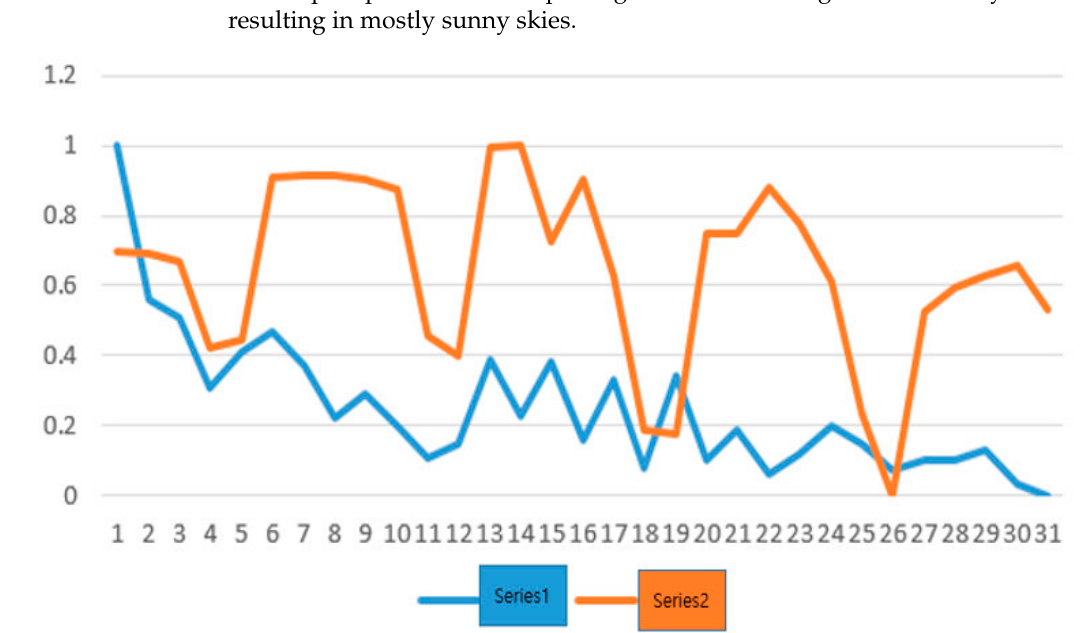
Figure 11. Daily power demand and search frequency for “intense heat” in August 2018.